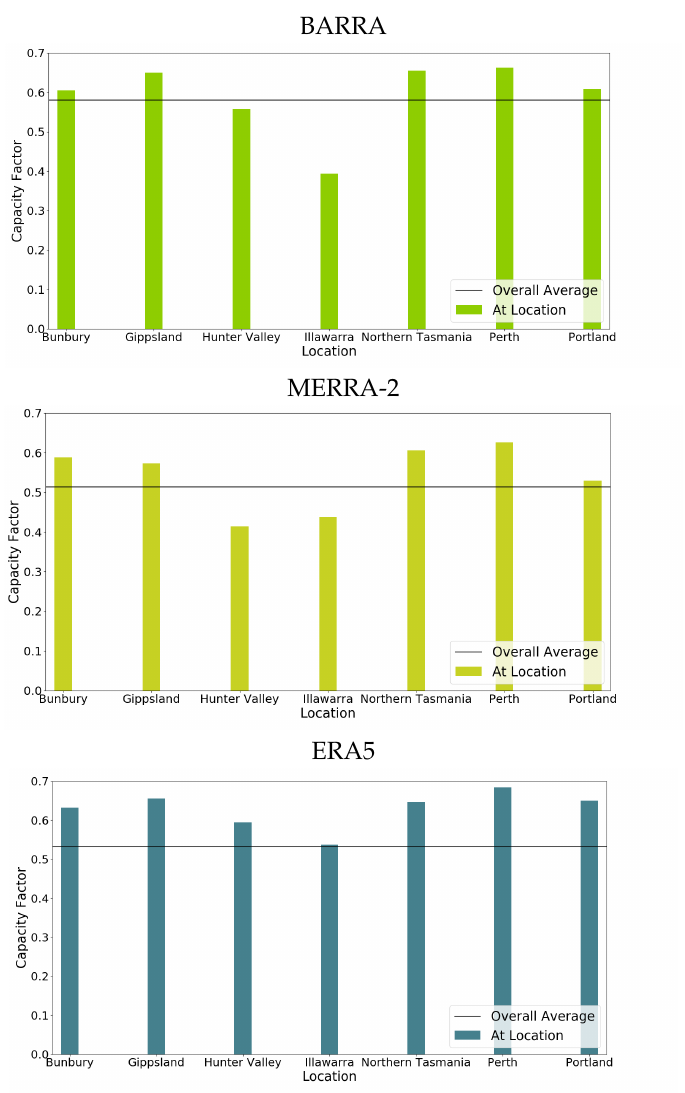
Figure 5. Average capacity factor (2009–2018) predicted using each dataset for key locations compared to whole-domain